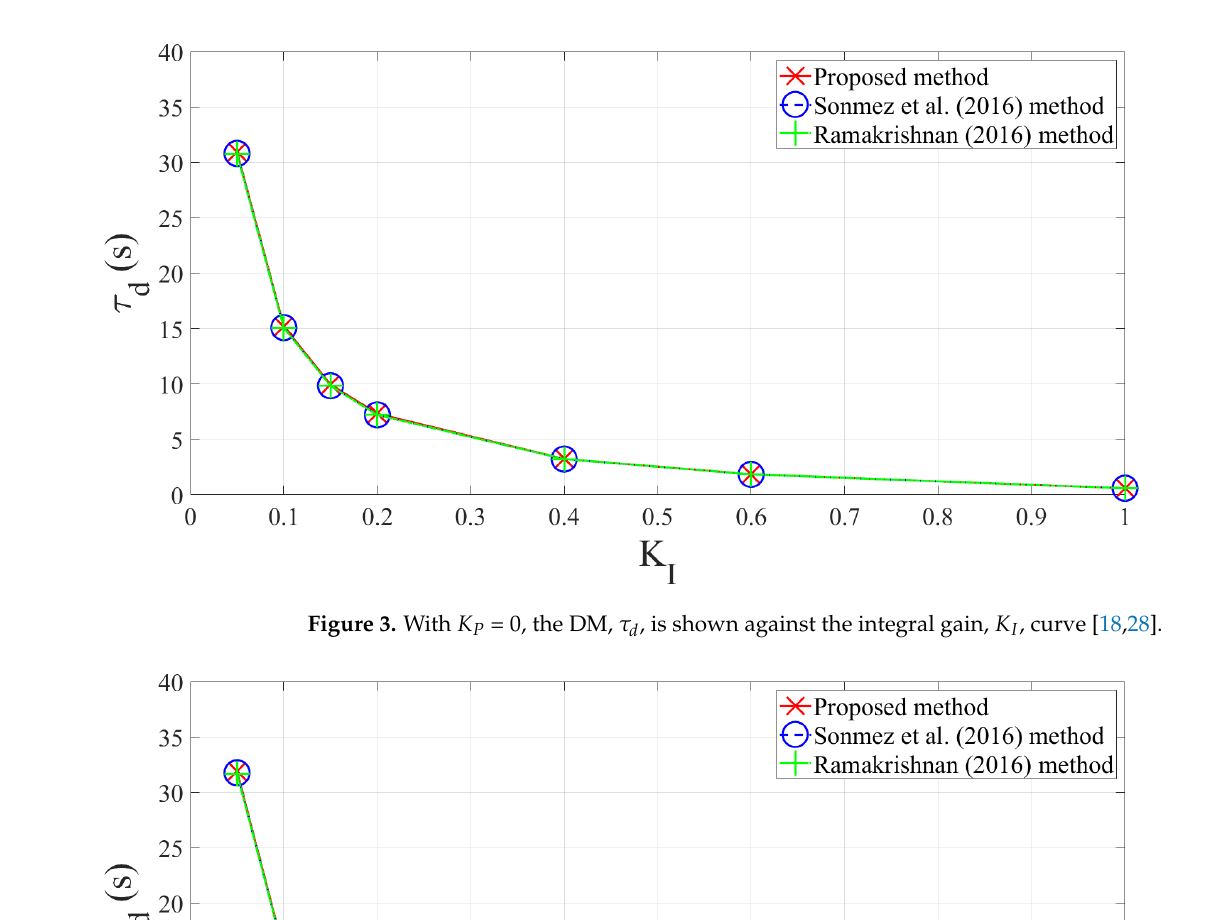
Figure 3. With K P = 0, the DM, τ d , is shown against the integral gain, K I , curve [18,28].